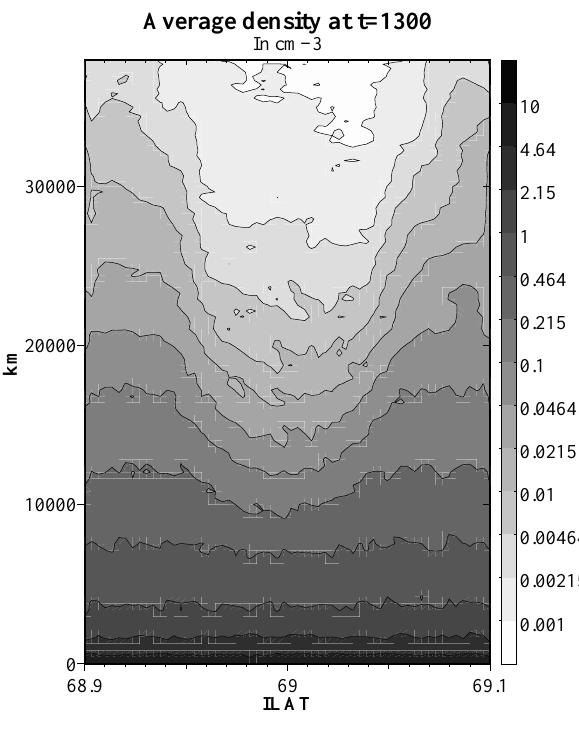
Fig. 9. Density of cold ionospheric ions at t = 1300s, averaged over the previous 10s.